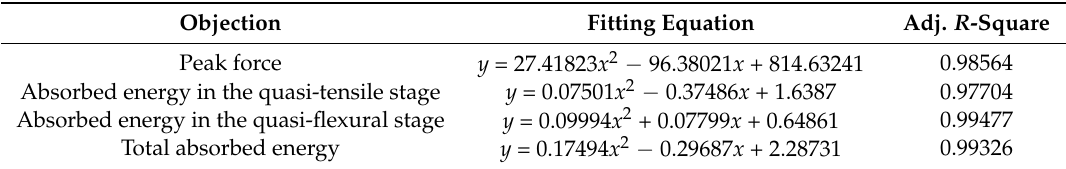
Figure 9. The impact properties of multi-CFPLs prepared by differently layered unit-CFPLs: ( a ) The force-distance curves of the multi-CFPLs with 1- to 5-layer unit-CFPLs; ( b ) the curve of the peak force versus layers; ( c – e ) are the schematic diagrams of the impact movement, a quasi-tensile stage and a quasi-flexural stage in an impact process; ( f , g ) are the energy absorption-distance and force-distance curves of the multi-CFPLs with 1-layer and 5-layer unit-CFPLs, respectively; ( h ) is the curves of energy absorption versus layers. Table 1. The fitting equations of peak force and absorbed energy for multi-CFPLs in the impact process, in which x represents the unit-CFPL layer numbers and y represents the